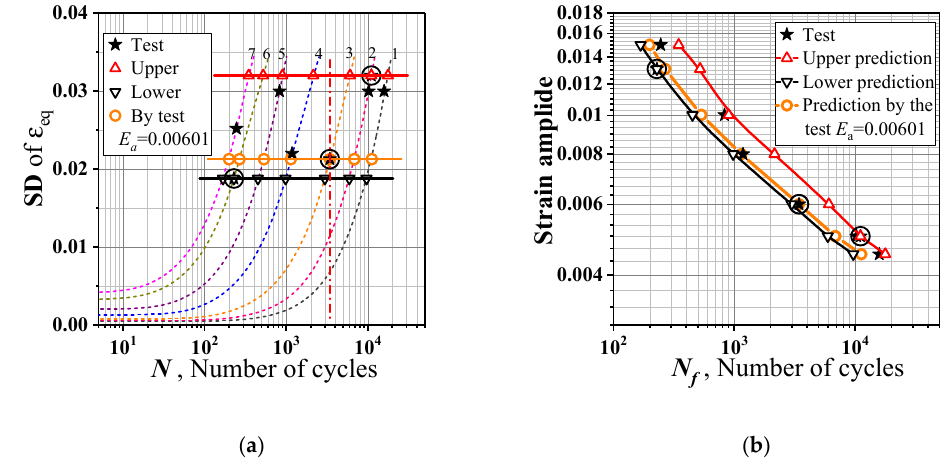
tests. termining point sequences ( N predict , E a ) ; ( b ) predicted fatigue–life curves and their comparison N E ; ( b ) predicted fatigue–life curves and their comparison with mining point sequences predict ( , ) f f a with tests. tests.